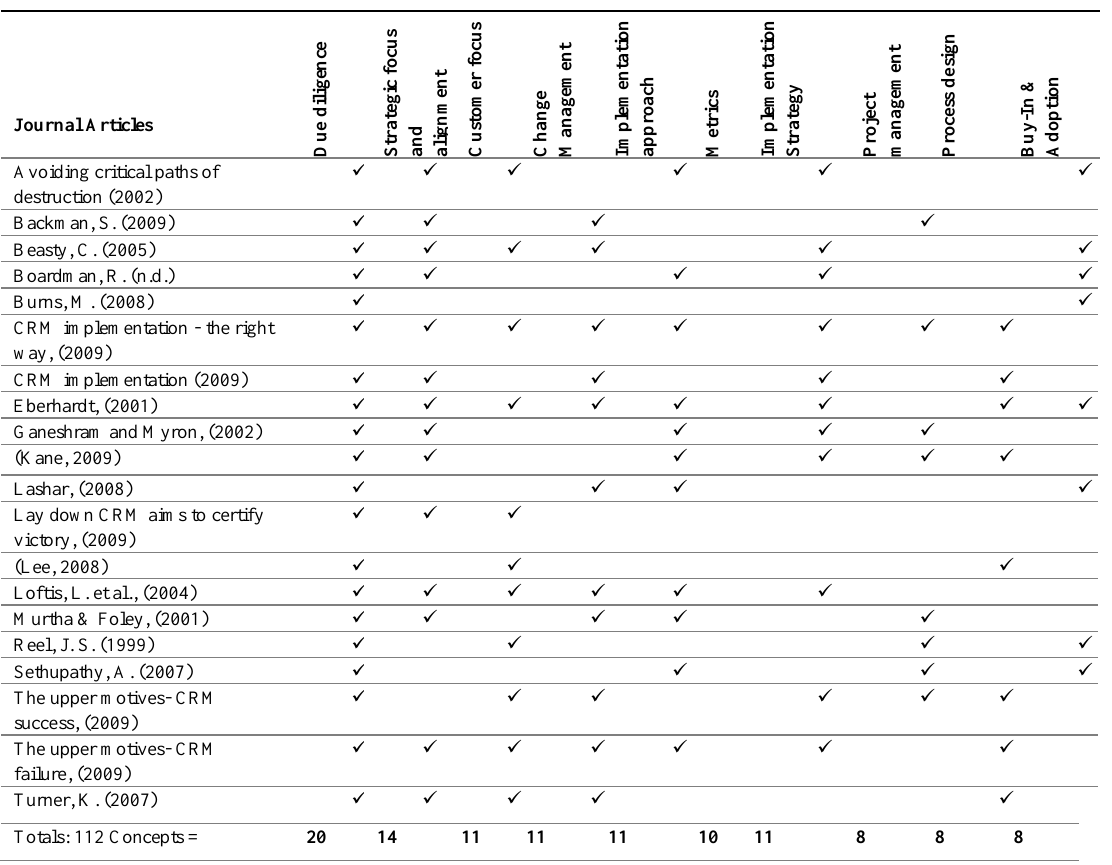
Table 1: Summary of the Critical Success